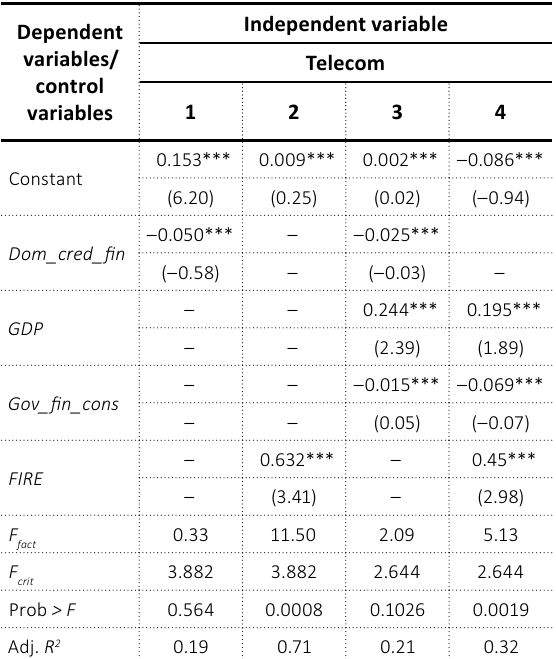
Table 2. Results of identifying the dependency between IMFR indicators and amount of